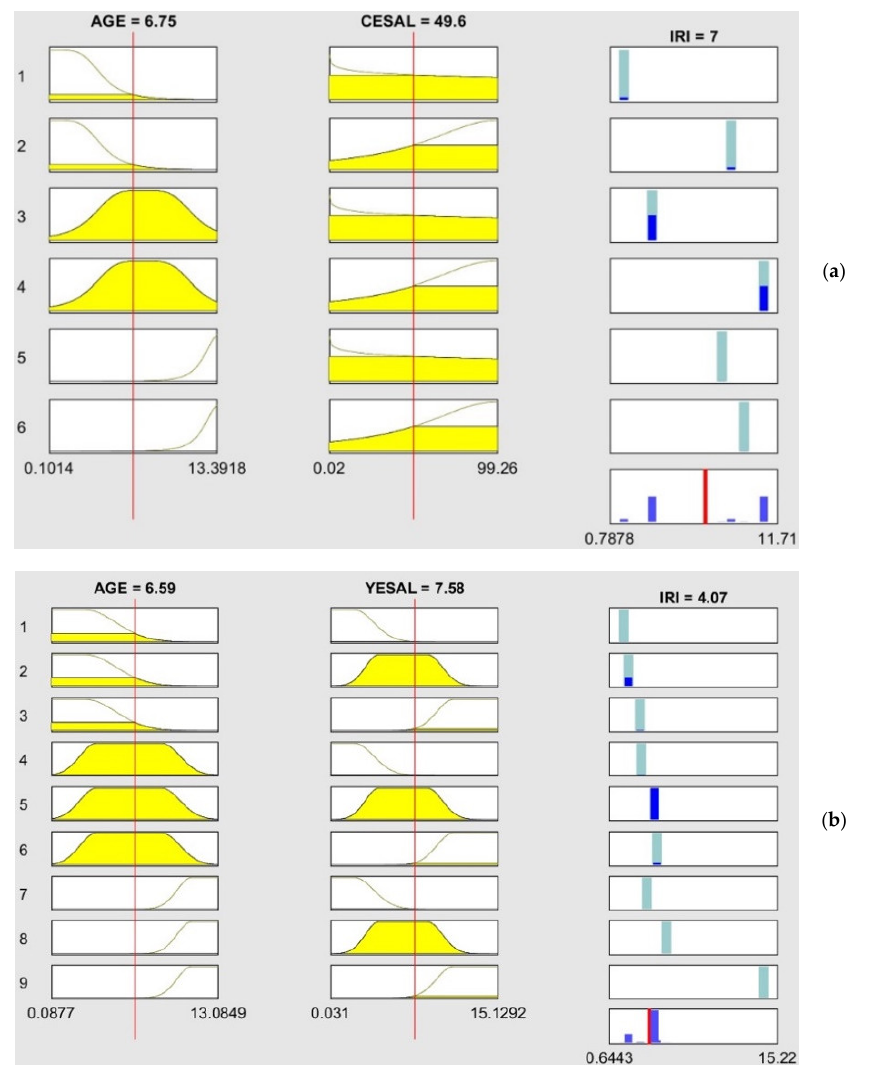
Figure 13. The rules of the optimum ANFIS structure for the ( a ) DBST model and ( b ) AC